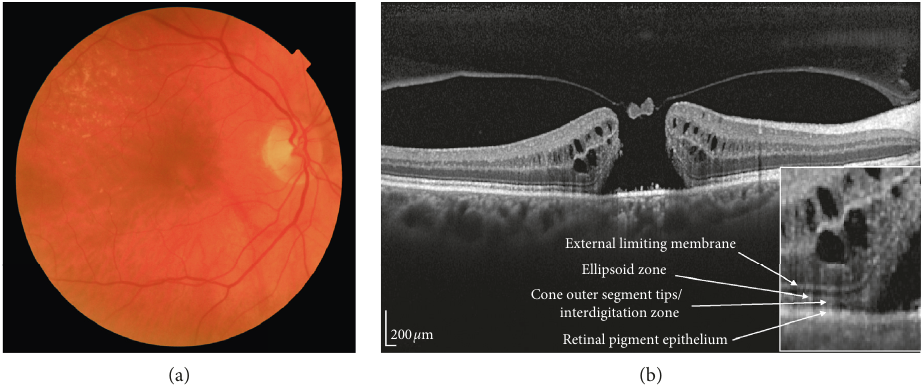
Figure 1: A spectral domain optical coherence tomography (SD-OCT) scan passing through the fovea in a patient with a large macular hole. (a) Color fundus of the patient; (b) SD-OCTscan showing a small operculum on the roof of the macular hole. Bottom right: magnification of the scan showing a detail of the four external retinal